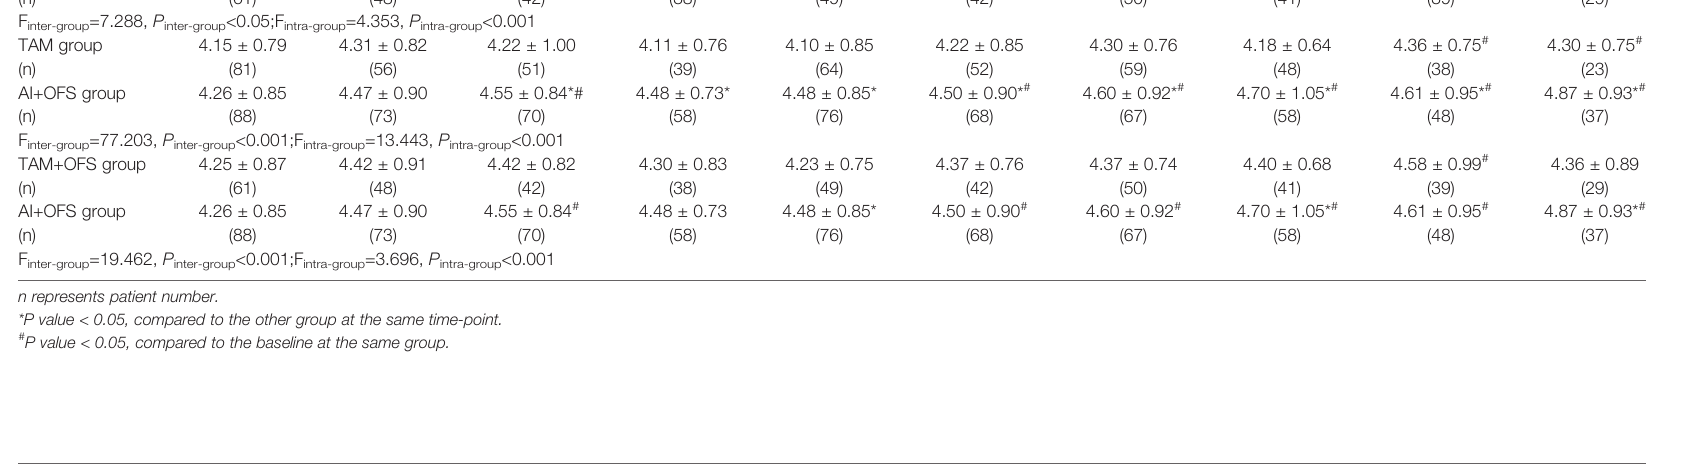
TABLE 5 | Comparison of triglyceride (TG) level at different time-points over the course of treatment. Group Baseline 3 months TAM group